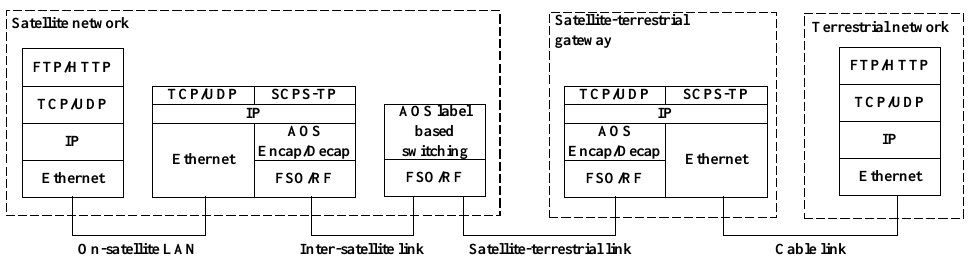
Figure 6. The protocol framework of